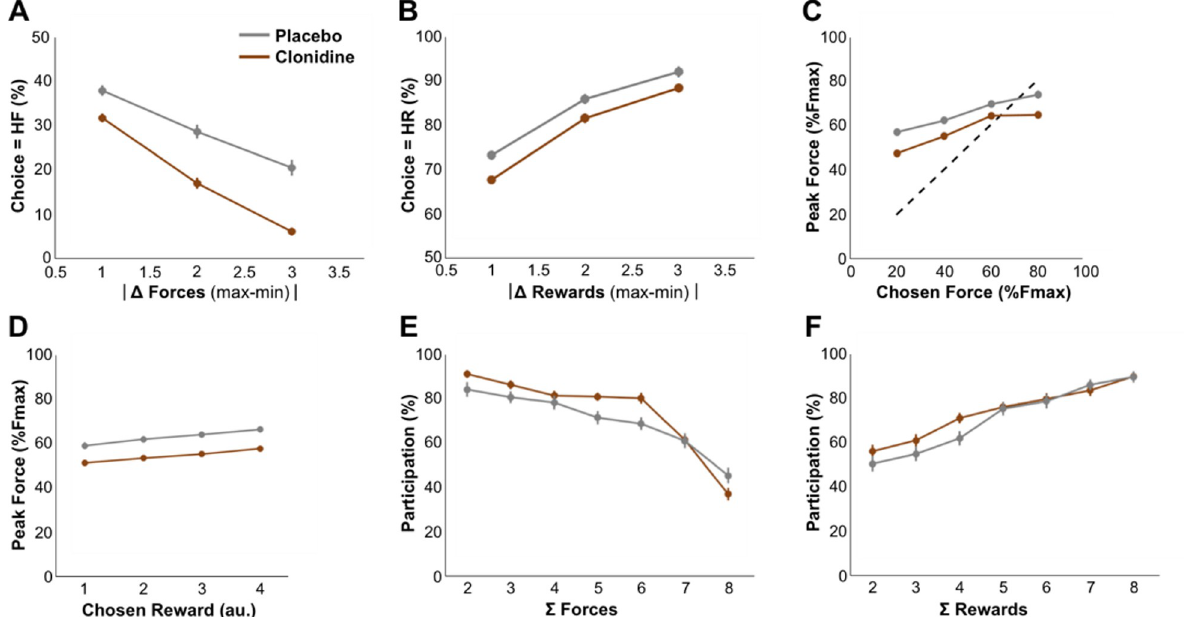
Fig 5. Clonidine affects choice and force production. Behavior of the monkeys under the placebo (gray) and clonidine (brown) conditions. Lines and dots represent group-level means (across monkeys) and error-bars represent SEM (across sessions). A. Relationship between the percentage of high-required force choices and the difference in offered forces. The weight of the difference in required force increased under clonidine (clonidine = − 2.55 ± 0.23, placebo = − 1.65 ± 0.28, F (1,145) = 14.81, p = 1.78 × 10 − 4 ). B. Relationship between the percentage of high-reward choices and the difference in offered rewards. Under clonidine, the weight of the difference in reward sizes did not change (clonidine = 2.29 ± 0.21, placebo = 2.45 ± 0.30, F (1,145) = 0.47, p = 0.49). C-D. Relationship between exerted force relation and chosen force level ( C ) and chosen reward size ( D ). The dotted line represents the optimal relation (identity) between exerted force and force difficulty (the minimum required force to complete the trial). Clonidine had a main effect on force production (clonidine = 0.55 ± 0.05, placebo = 0.63 ± 0.03, F (1,145) = 20.70, p = 1.12 × 10 − 5 ), without affecting the effects task factors (reward weights: clonidine = 0.02 ± 8.3 × 10 − 3 , placebo = 0.02 ± 5 × 10 − 3 , F (1,145) = 0.93, p = 0.33; required force weight: clonidine = 0.06 ± 0.01, placebo = 0.05 ± 0.01, F (1,145) = 0.92, p = 0.33). E-F. Relationship between participation and the sum of offered forces ( E ) and sum of offered rewards ( F ). There was a tendency for an increase in the weight of the sum of required forces that did not reach significance (clonidine = − 0.75 ± 0.18, placebo = − 0.46 ± 0.04, F (1,145) = 2.02, p = 0.16) ( E ) but no effect of clonidine on the modulation of participation by the sum of rewards ( F ). Underlying data can be found in S1 Data. au.,arbitrary units; Fmax, maximal force; HF, high force; HR, high